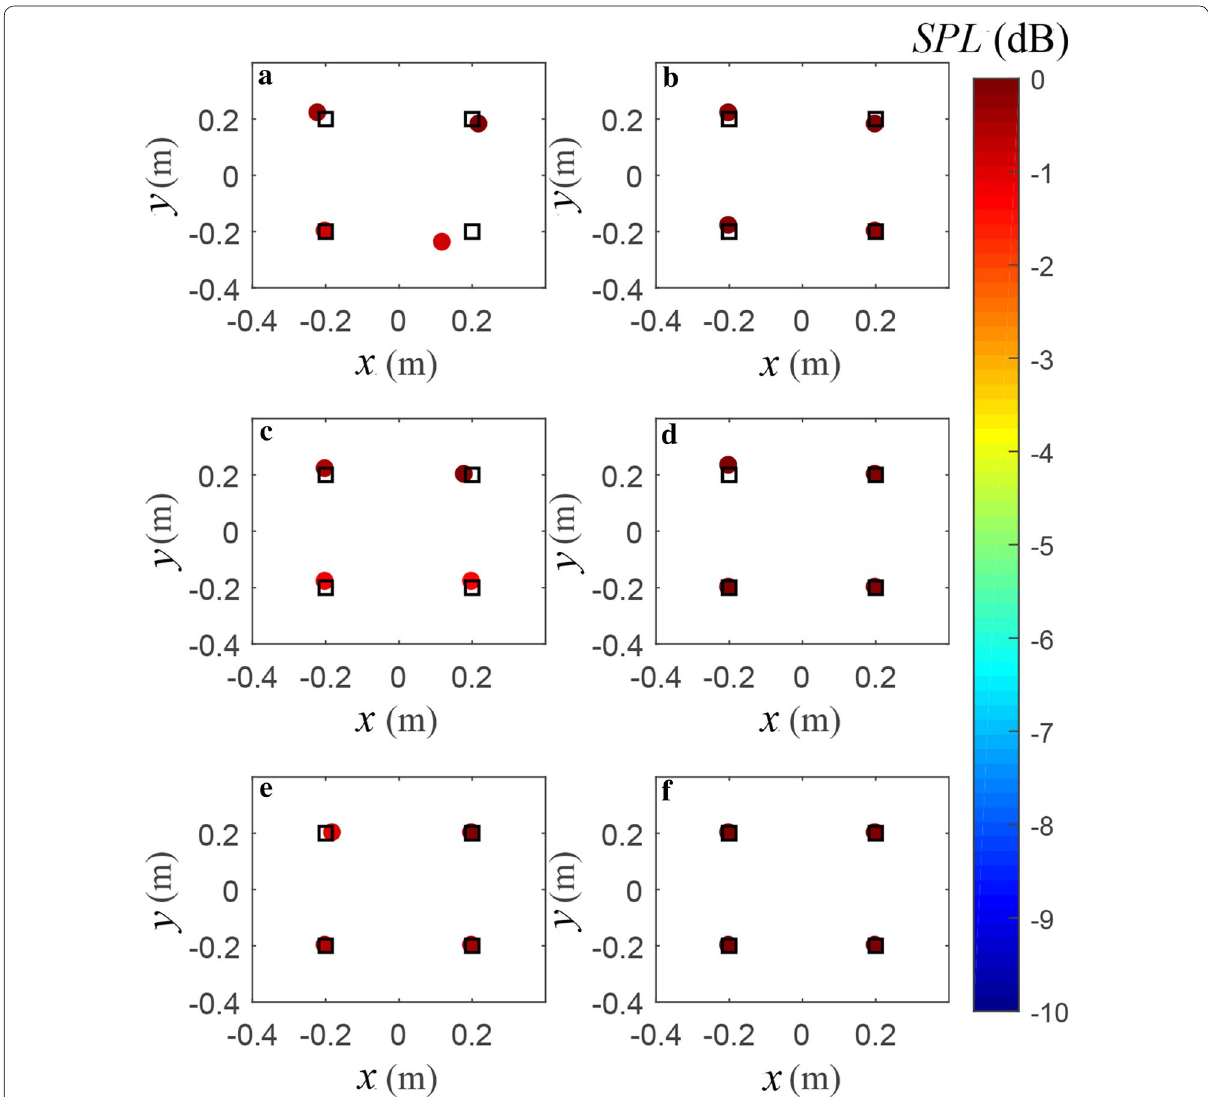
Figure 8 Source maps obtained by the DCS-SOMP method and the DCS-SOMP-SVD method as the frequency ranges equal 1000 ‒ 1500 Hz, 1000 ‒ 2000 Hz and 1000 ‒ 3000 Hz: a , c , e show the maps obtained by the DCS-SOMP method; b , d , f show the maps obtained by the DCS-SOMP-SVD method